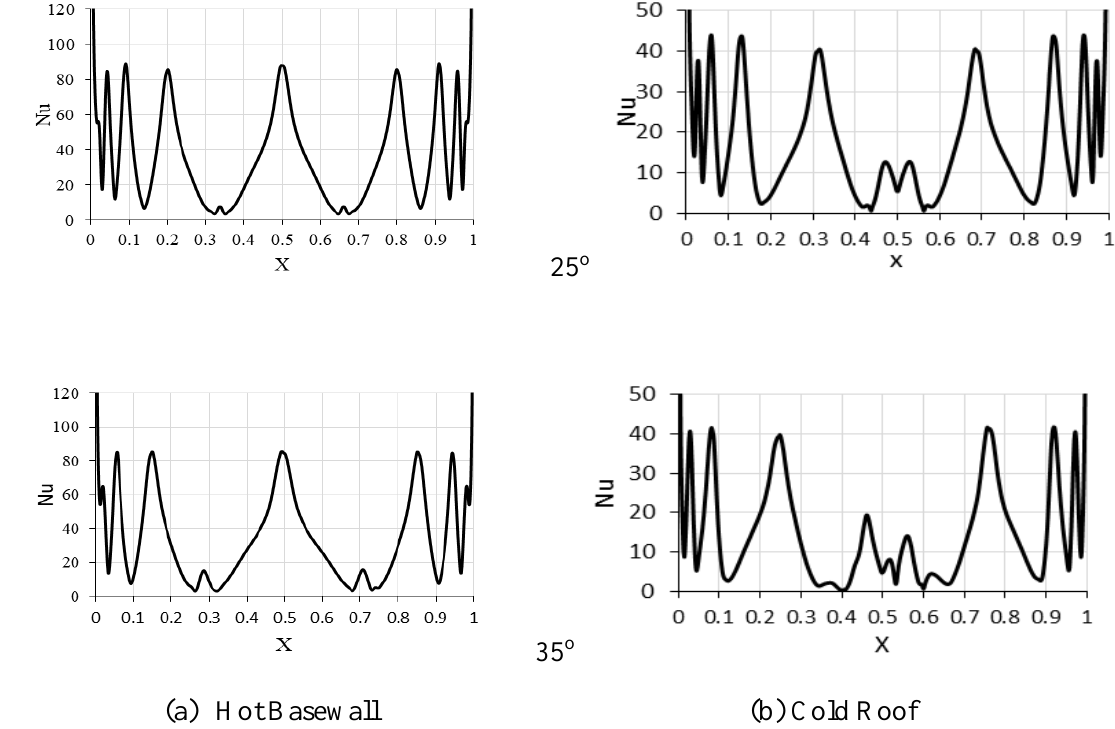
Fig. 10. Local Nusselt number plots along the (a) hot basewall, and (b) cold roof for different pitch angles.